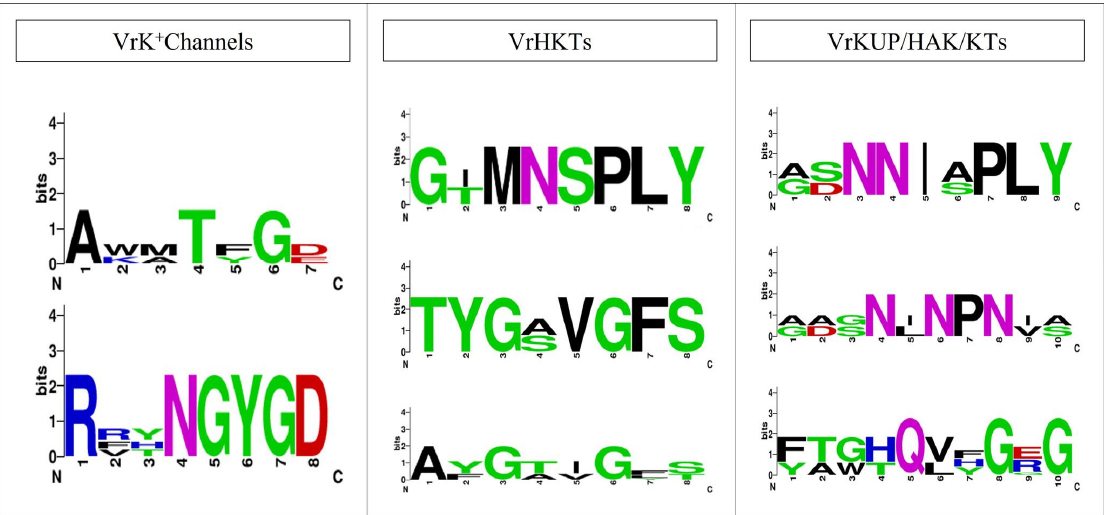
Figure 2. Conserved motifs present in the alignment of K + channels and the transporters’ protein sequences from V. radiata , O. sativa and A. thaliana . The overall height of each column indicates conservation at that position in the alignment, whereas the height of each letter within the column indicates the relative frequency of each amino acid at that